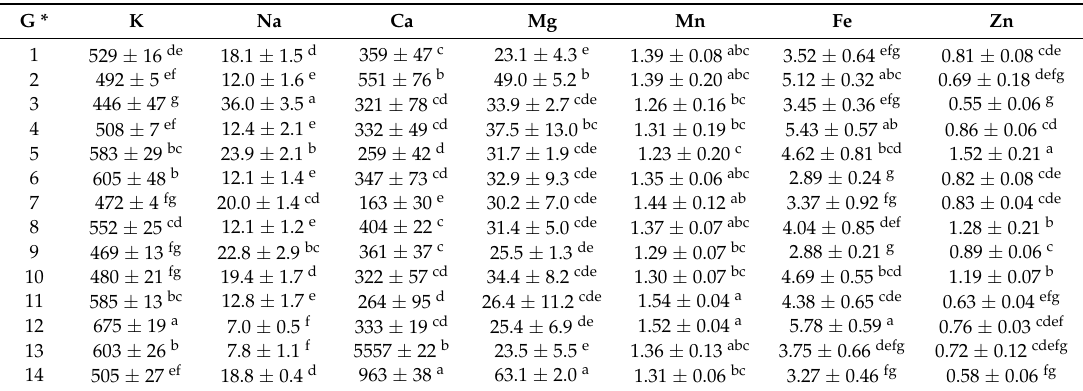
* G: genotypes; In each column different Latin letters mean significant differences between samples ( p <